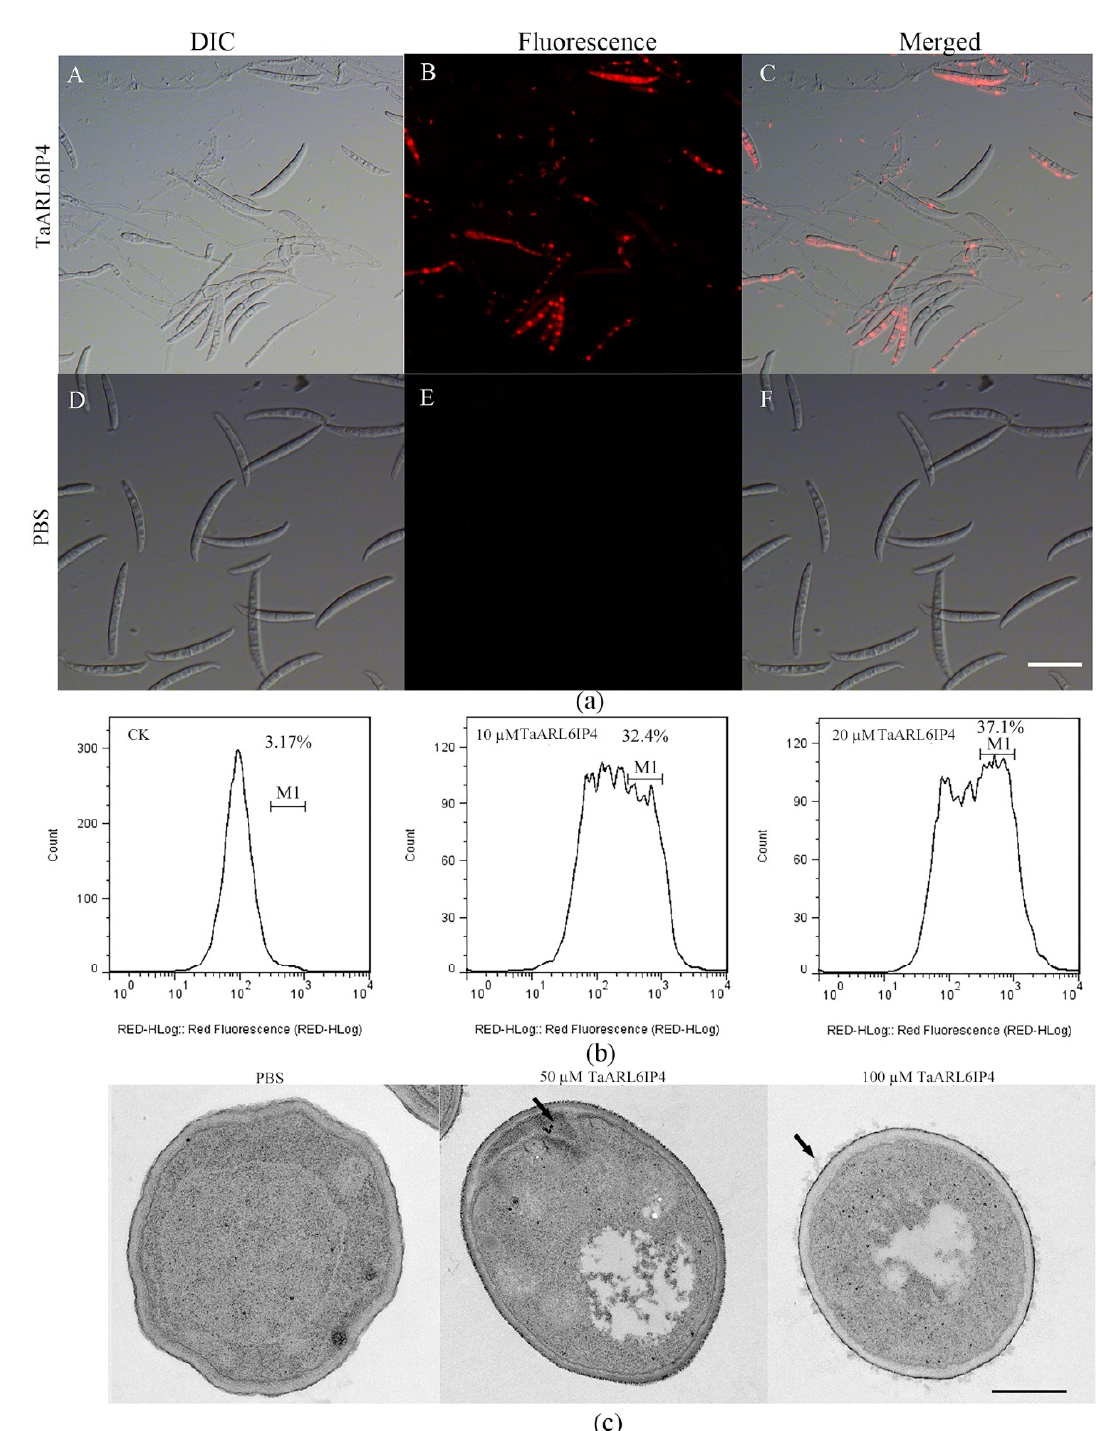
Figure 5. F. graminearum membrane disruption and leakage of cytoplasmic materials caused by TaARL6IP4 treatment. ( a ) PI intake assay by fluorescence microscopy. The F. graminearum spores (2 × 10 6 mL –1 ) were incubated with TaArl6ip4 ( A – C ) or PBS buffer ( D – F ) at 28 °C for 4 h, and the red fluorescence was detected by microscopy (Bar = 20 µm). ( b ) Flow cytometry assay of PI-stained F. graminearum spores treated with PBS buffer (control) or 10 or 20 µM of the TaARL6IP4 peptide. The x -axis represents the relative fluorescence intensity. M1 = events of necrotic cells with the given fluorescence intensity. ( c ) Morphological change assay by transmission electron microscopy. Spores were treated with PBS (control) or 50 or 100 µM of the TaARL6IP4 peptide at 28 °C for 4 h. Black arrows indicate plasma membrane infoldings and leaked out cytoplasmic materials (Bar = 500 nm).